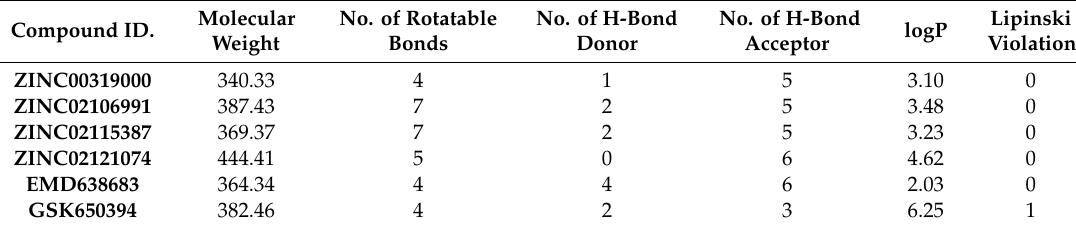
Table 1. The physicochemical properties of four potentially selective compounds against SGK1. Compound